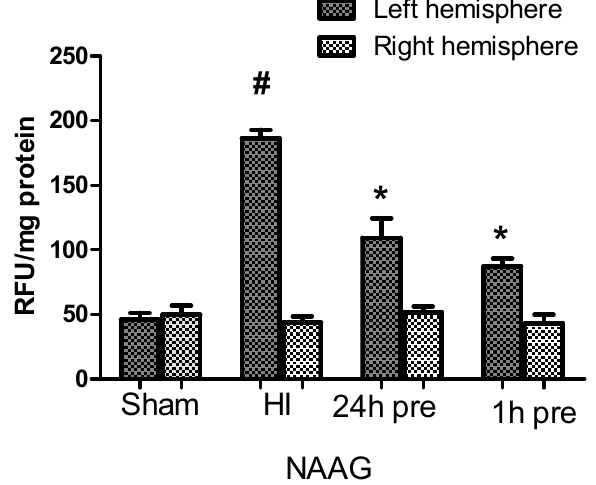
Figure 3. Effects of NAAG application on changes in ROS levels observed in the rat brain after HI. The results are presented as the means ± SEM, n = 6; statistically significant differences: * p < 0.001, compared to the HI group; # p < 0.001 compared to the sham operated group.